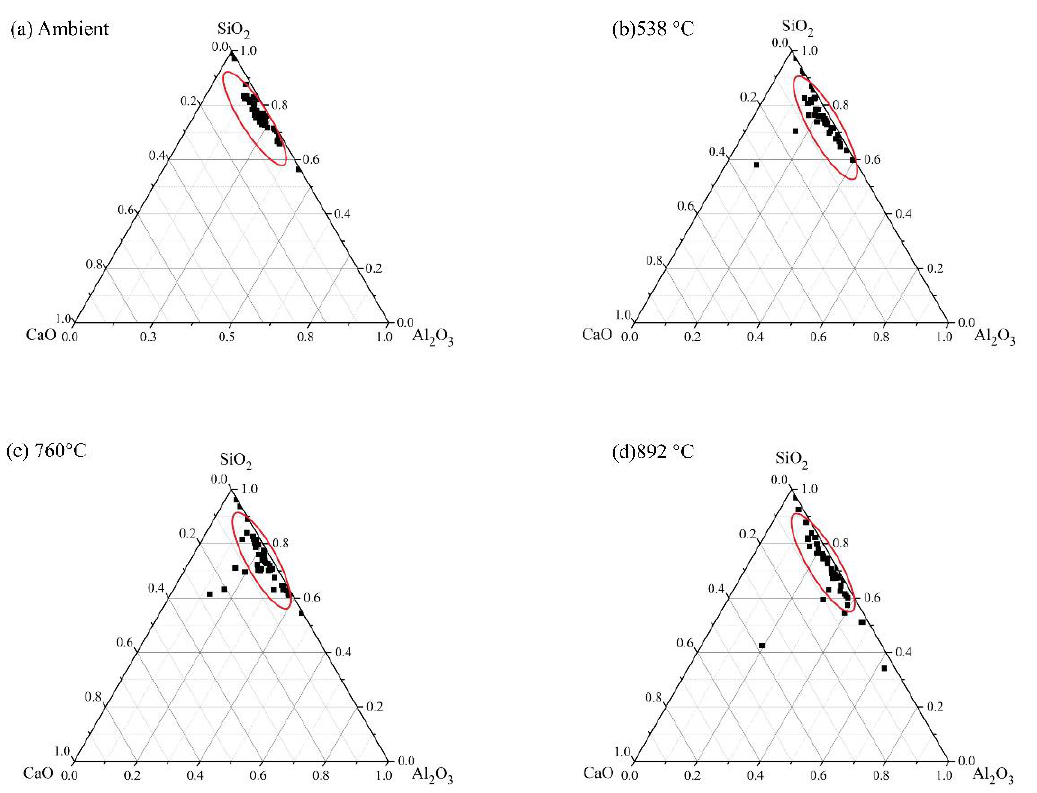
Figure 20. Ternary representation of EDS data for FS 0P-1.4 exposed to high temperatures.